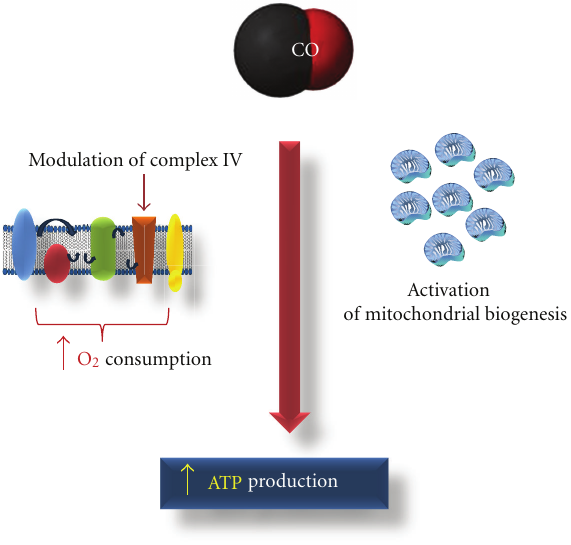
Figure 3: CO controls mitochondrial functioning and improves cellular energetic state (increased ATP generation) by two main ways: enhance of oxidative phosphorylation and induction of mito- chondrial